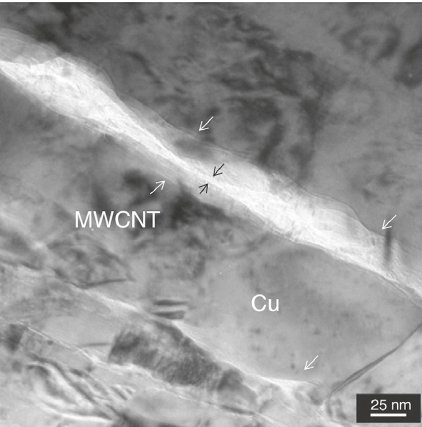
Figure 9: TEM imaging of a cold-sprayed CNT-Cu MMC coating produced by low-pressure cold spray